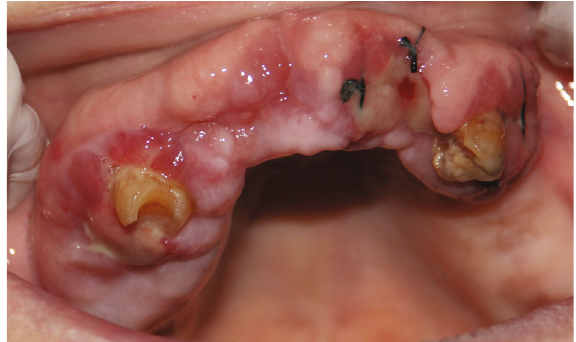
Figure 10: Recall after 2 weeks of surgical intervention of maxillary arch. Pus and exudates were observed around teeth and sutures. Full exodontia was done for the remaining teeth in the upper